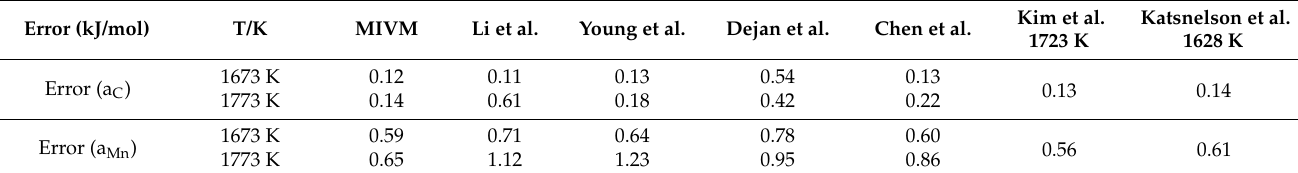
Table 4. Errors ( a Mn and a C ) in Mn-C liquid alloys at 1673 K and 1773 K calculated using different models or experimentally measured by Kim et al. at 1723 K and Katsnelson et al. at 1628 K.